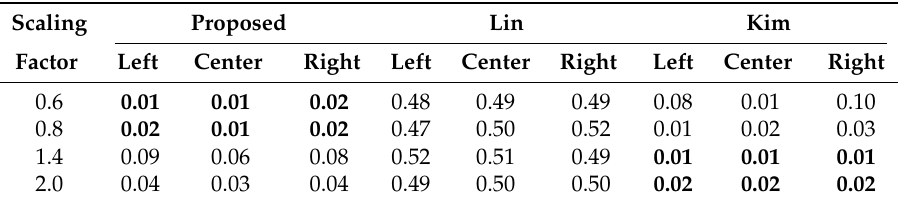
Table 9. Average BER for scaling attack.